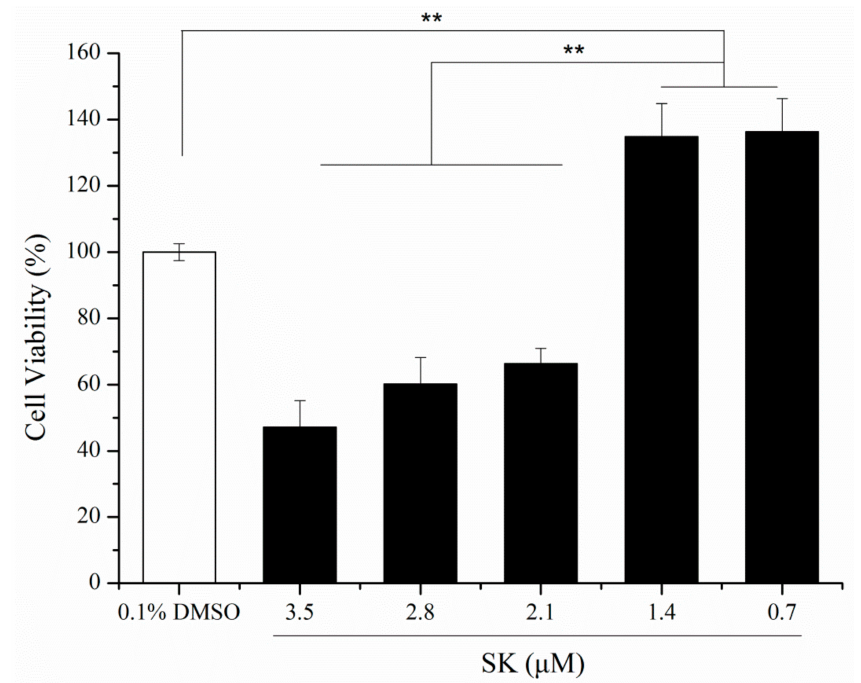
Figure 1. Cell viability of shikonin component. ** p < 0.01 compared with the control